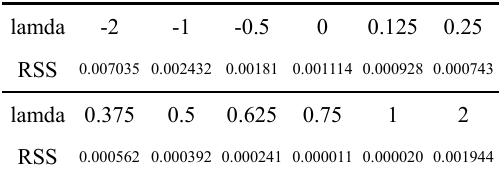
Table 4 Correspondence between transformation